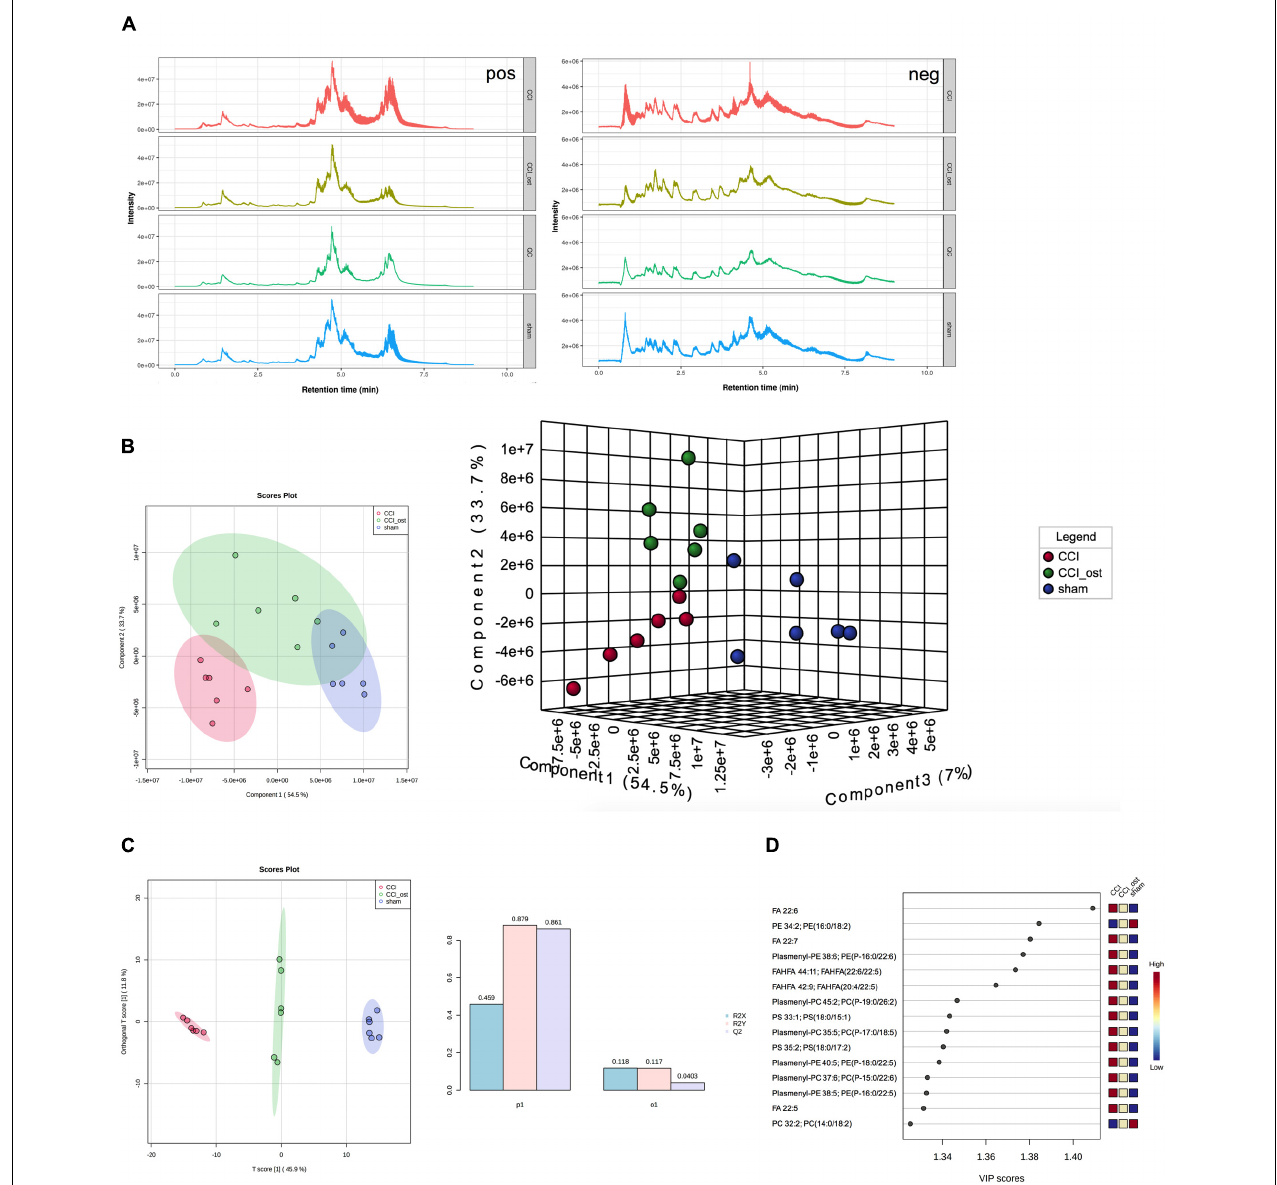
FIGURE 5 | Osthole treatment changed serum metabolites in chronic constriction injury (CCI) mice. (A) Total ion flow of mice in each group under positive and negative ion mode. (B) PLS-DA 2D and 3D diagram. (C) OPLS-DA analysis. (D) The variable important for the project (VIP) value of differentially expressed MS2